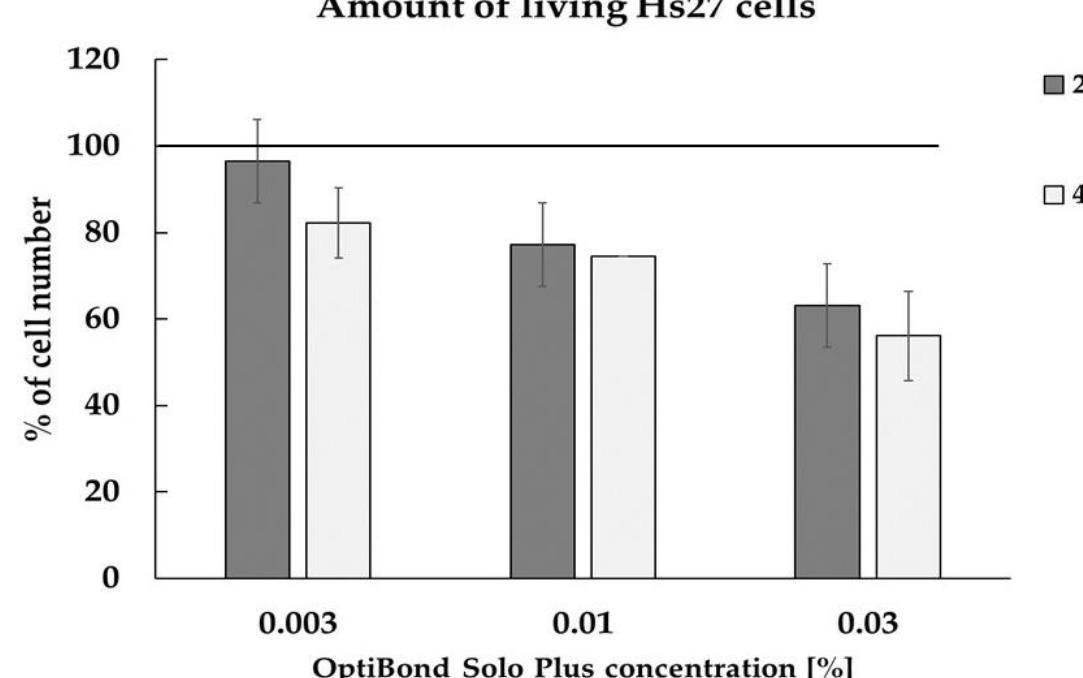
Figure 2. Cell number in Hs27 cell line after the 24- and 48-h incubations with OptiBond Solo Plus by crystal violet staining. The line at the 100% level represents the number of cells stained at the time when all OptiBond concentrations were added to the cell culture medium. The data represent a mean with SD values from at least three independent experiments with technical repetitions.